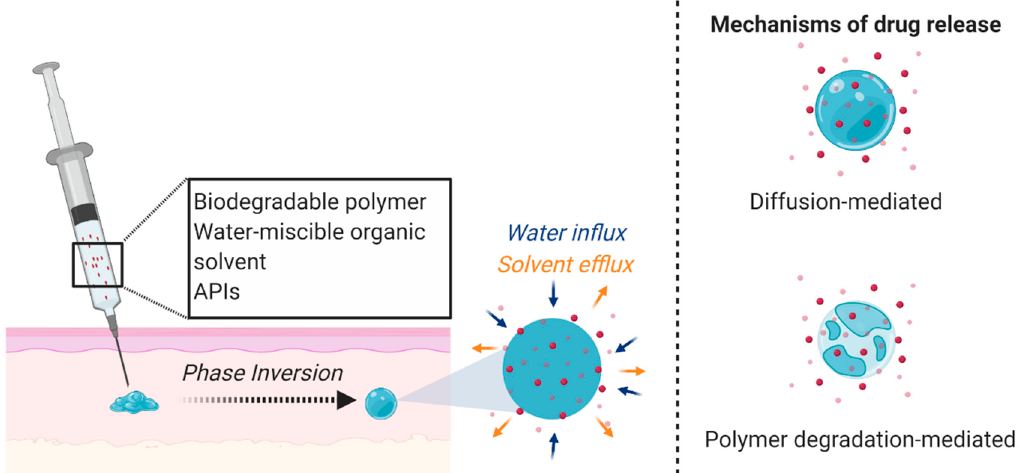
Figure 1. ISFI mechanism and drug release. A liquid solution incorporating a biodegradable polymer, water-miscible organic solvent, and APIs is subcutaneously administered and undergoes a phase inversion due to solvent exchange under physiological conditions to form a semi-solid or solid drug-loaded depot. The APIs are released through diffusion or as the polymer degrades. Figure created with BioRender.com, accessed on 7 October 2020.